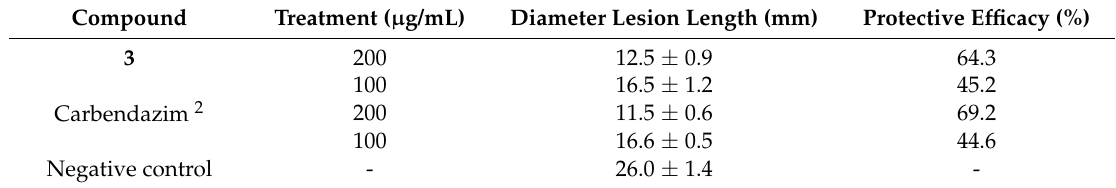
Table 4. In vivo efficacy of compounds on cole leaves infected by S. sclerotiorum